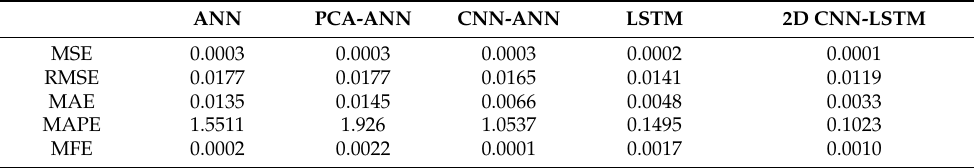
Table 10. The Amount of Each Measure for pre-COVID-19 with Five-Day-Ahead